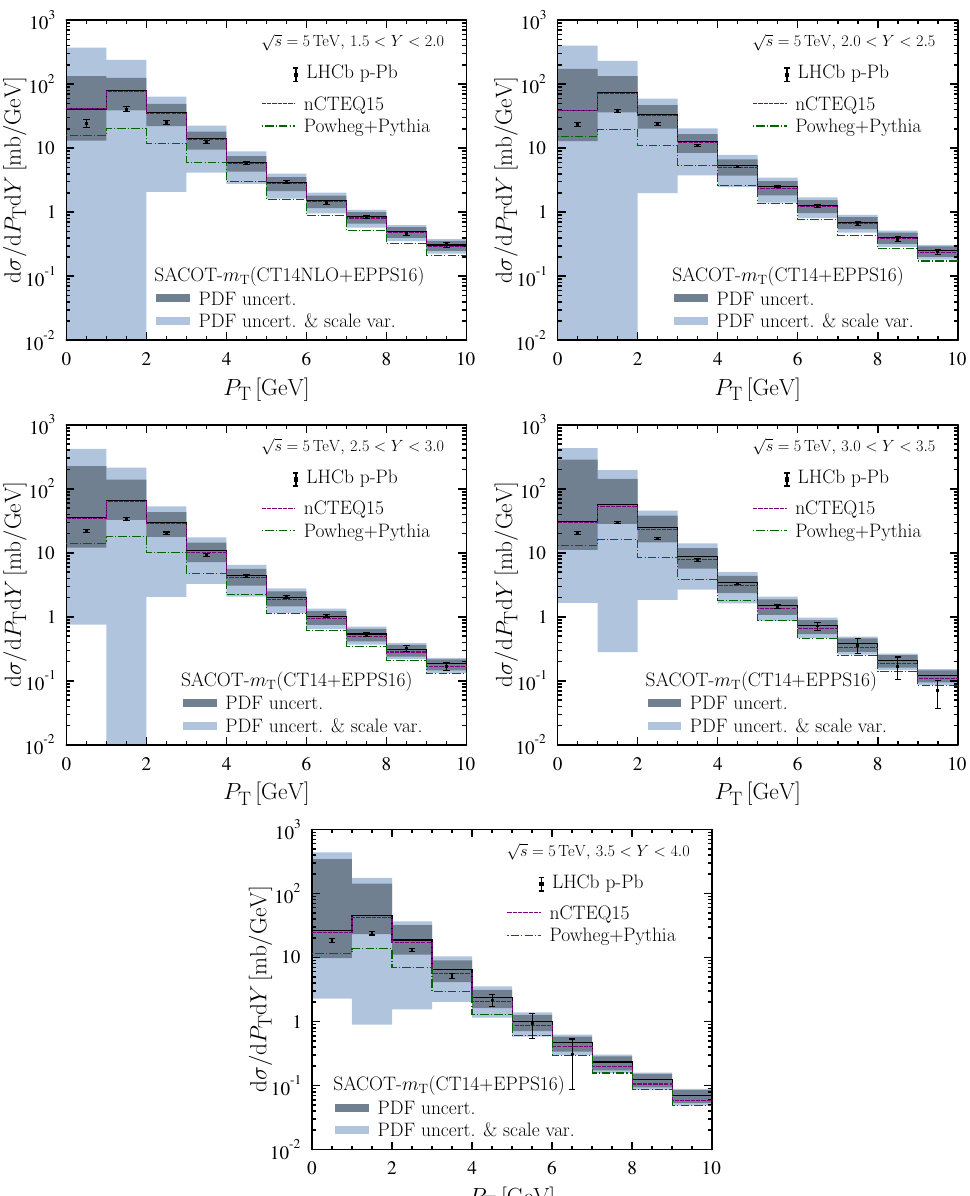
Figure 2 . Same as (cid:12)gure 1 but at forward